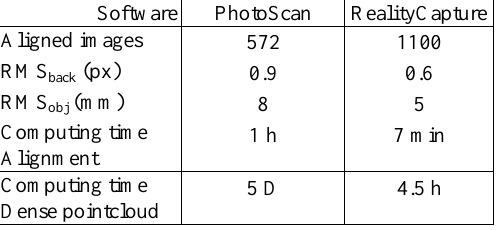
Table 3. Photogrammetric processing